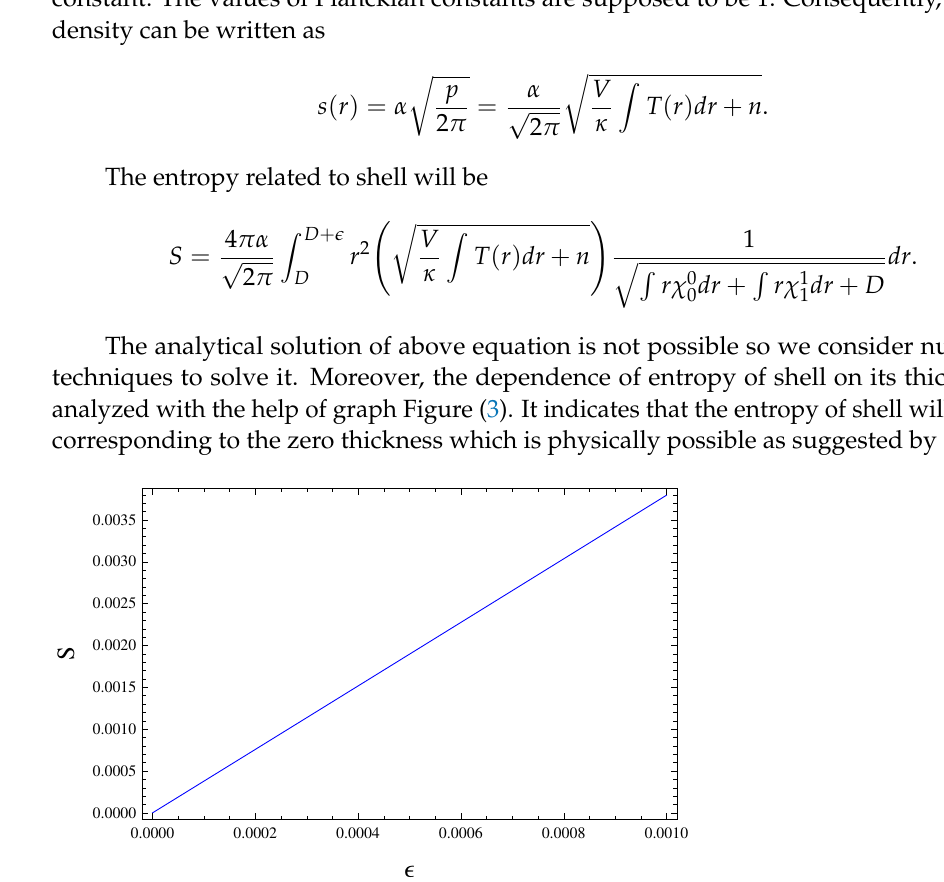
Figure 3. Graphical representation of entropy S (km) relationship with shell thickness (cid:101)